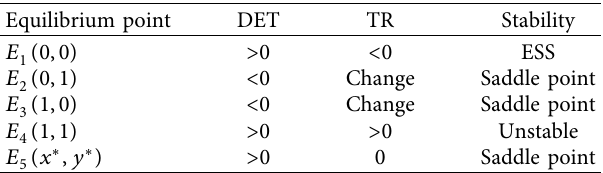
Table 5: Stability analysis of strategy system ( c ) of the government and enterprise.